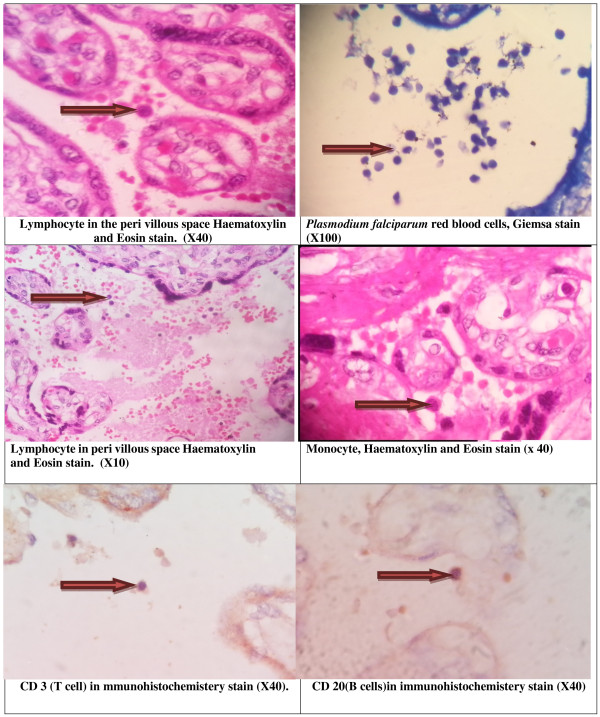
Placental malaria and lymphocytes infiltrations.